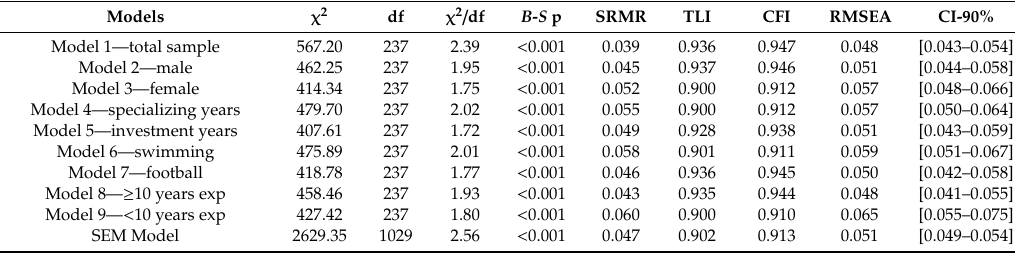
Table 3. Goodness-of-fit indexes of Basic Psychological Needs Satisfaction and Frustration Scale (BPNSFS) in all samples under